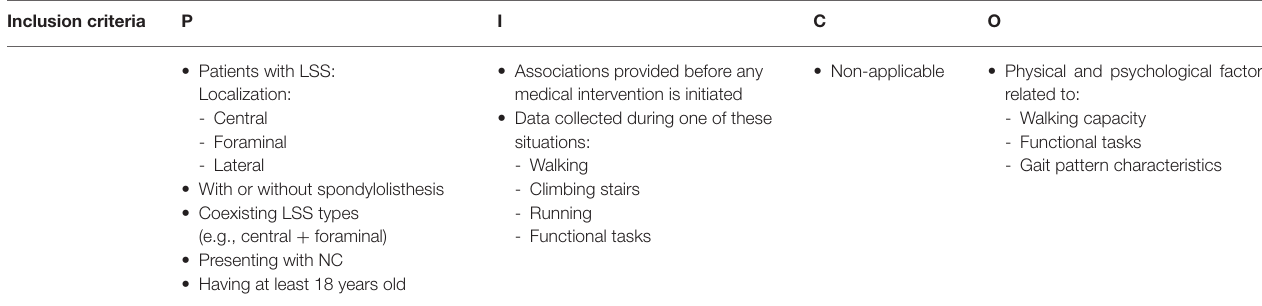
TABLE 1 | Inclusion criteria regarding population, intervention, and outcomes measures. Inclusion